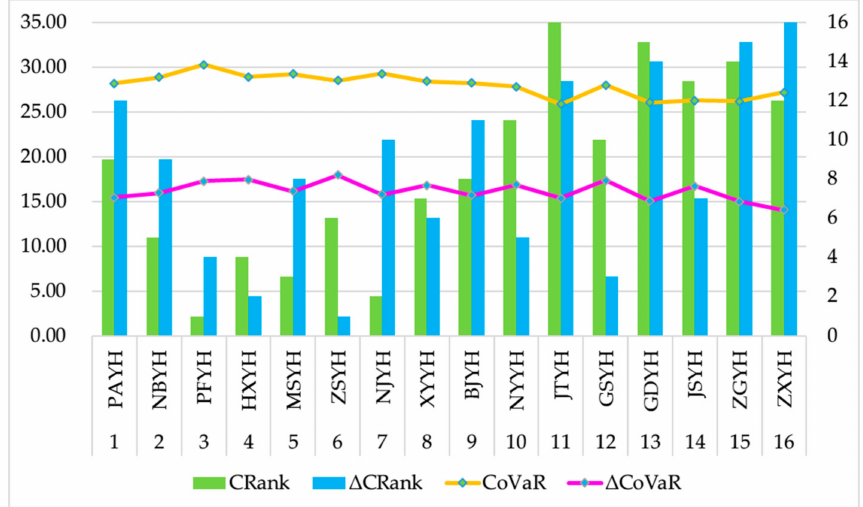
Figure 6. The overall results of CoVaR and ∆ CoVaR (In the figure, the CoVaR refers to the Conditional Value at Risk when a bank is in distress; ∆ CoVaR refers to the di ff erence between the CoVaRs when the bank is in distress and in a normal state)